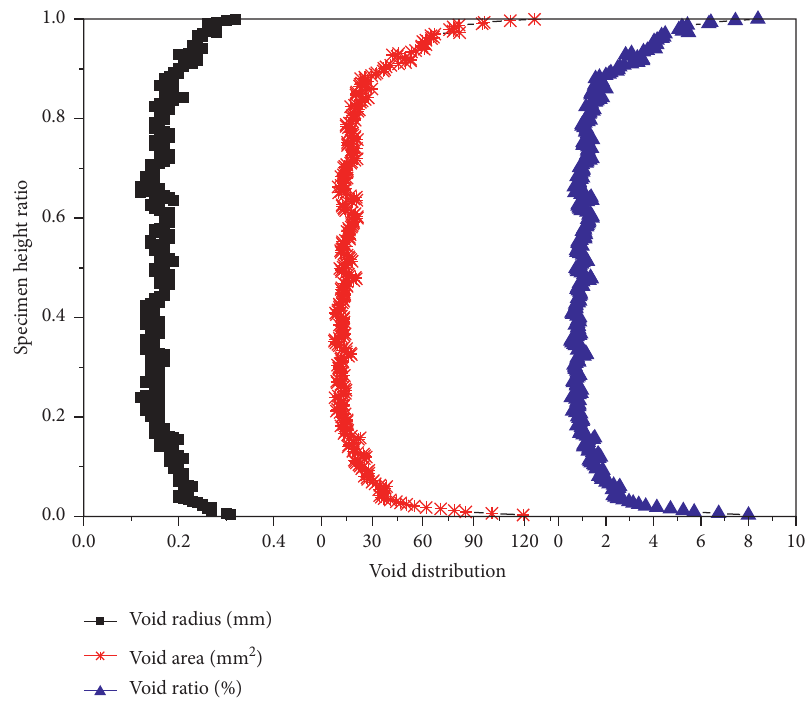
Figure 7: Air size distributions along with the AC13 specimen height ratio.